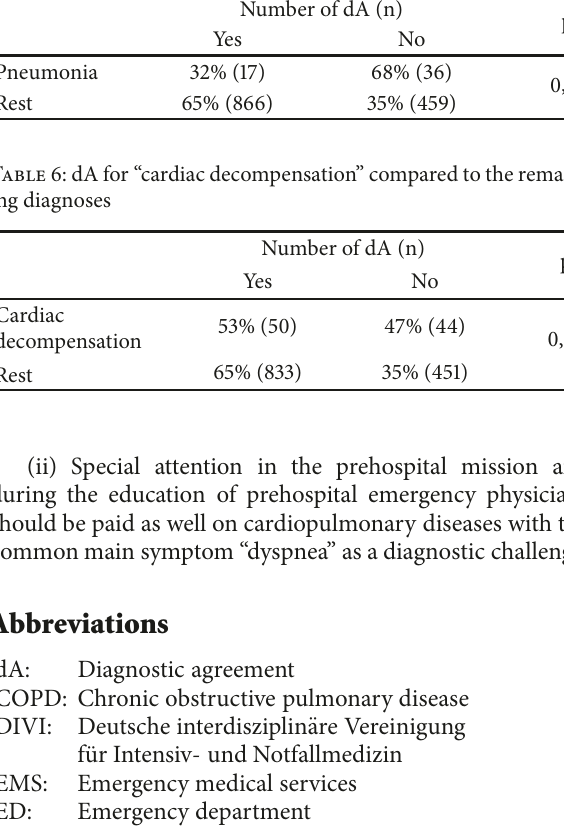
Table5:dAfor“pneumonia”comparedtotheremainingdiagnoses.